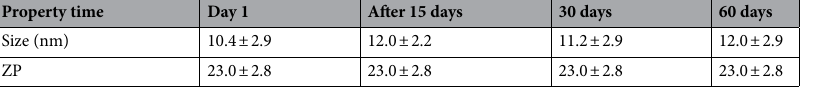
Table 1. Variations in DA-nanoparticles characteristics with respect to time. Data are expressed as Mean ± S.E.